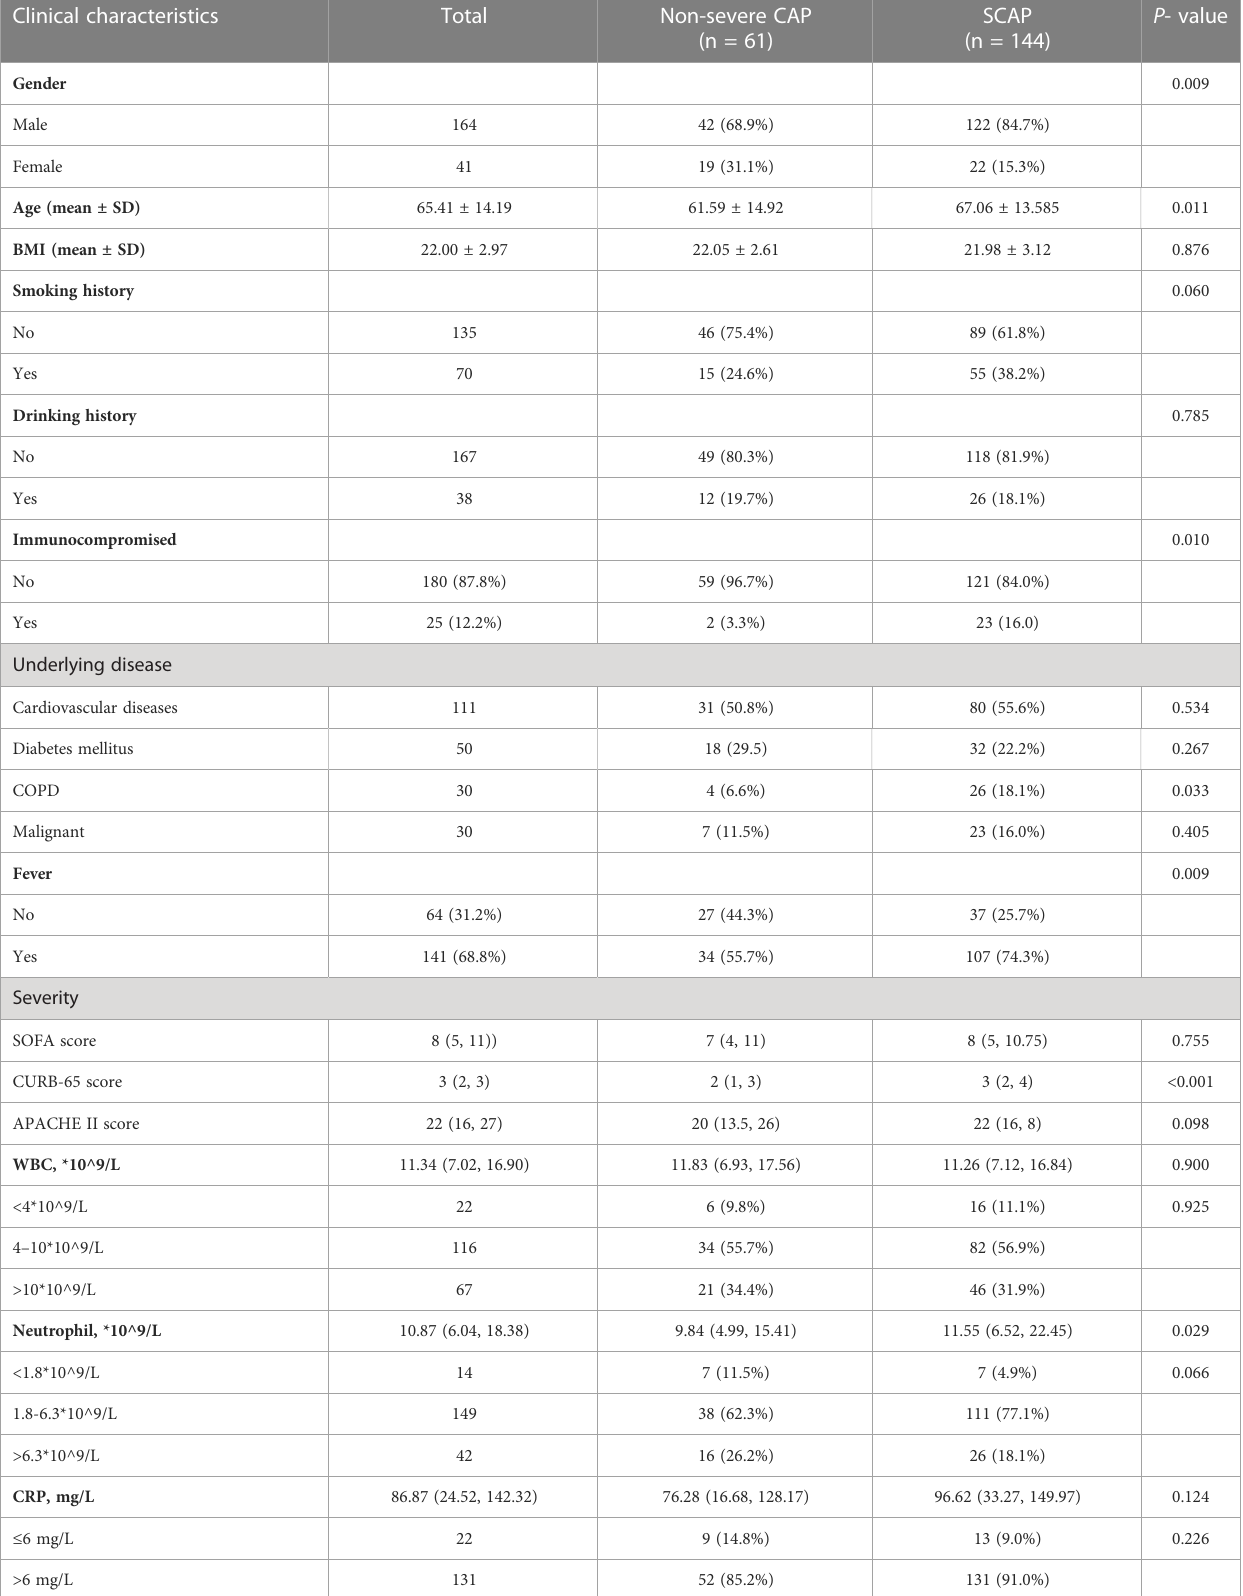
TABLE 1 Baseline characteristics and clinical manifestation of 205 patients with community-acquired pneumonia in the study on